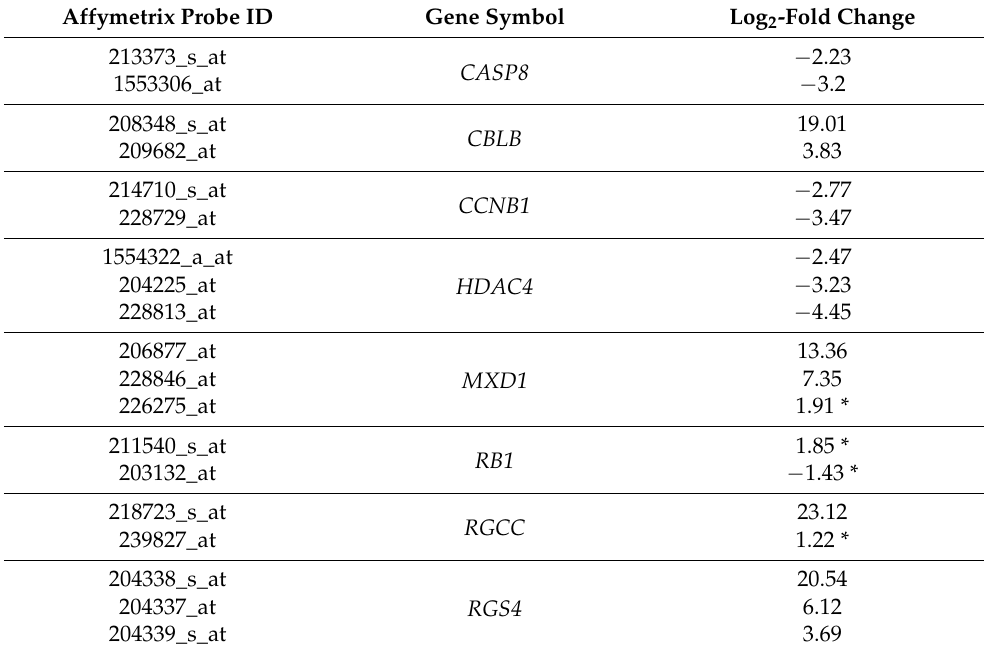
Table 1. DNA microarray data with changes in gene expression for Poly E-treated PC-3 cells. Affymetrix GeneChipTM Human Genome U133 Plus 2.0 Array platform probe sets targeting